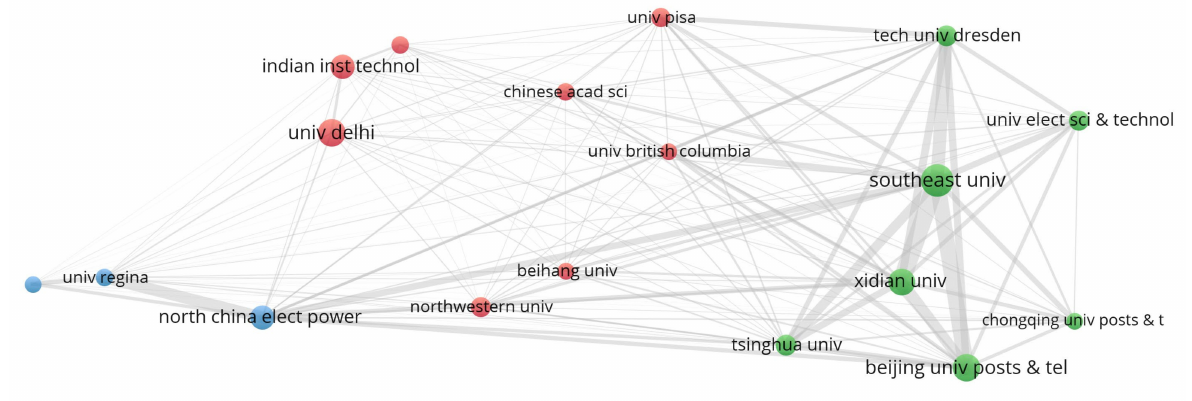
Figure 8. Co-authorship collaboration of the 15 most collaboration-intensive